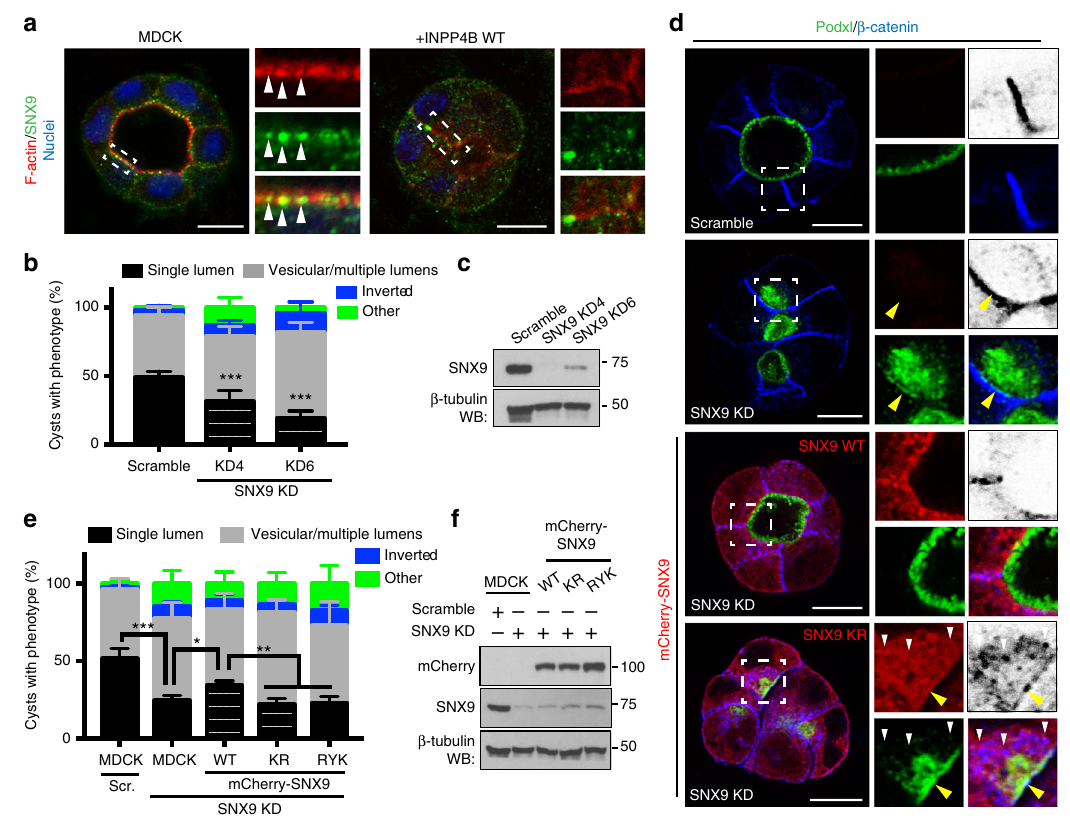
Fig. 9 SNX9-PI(3,4)P 2 association is essential for lumen formation. a SNX9, F-actin and nuclei labeling in cysts at 48 h without or with INPP4B WT overexpression. White arrowheads, subapical SNX9 puncta. b Quantitation of cyst phenotypes upon control (scramble) or SNX9 KD using two independent shRNAs. Mean ± s.d., n ≥ 300 cysts assessed from three wells/condition/experiment, three independent experiments. P- values: two-way ANOVA. *** P ≤ 0.0001. c Western blot of SNX9 and β -tubulin expression in cells stably expressing either scramble or SNX9 shRNAs. d Control (scramble) and SNX9-depleted cysts without or with co-expression of RNAi-resistant WT or PIP-binding defective mutant (KR) mCherry-SNX9 (red) stained for Podxl (green) and β -catenin (blue, inverted greyscale in cropped regions). Yellow arrowheads, basolateral; white arrowheads, vesicular β -catenin and SNX9. e Quantitation of cysts phenotypes in control (scramble) or SNX9-depleted cysts without or with expression of RNAi-resistant wild-type mCherry-SNX9 or PIP-binding defective mutants of SNX9 (KR and RYK). Mean ± s.d., n ≥ 300 cysts assessed from three wells/condition/experiment, three independent experiments. P- values: two-way ANOVA. * P ≤ 0.05, ** P ≤ 0.005, *** P ≤ 0.0001. f Total cell lysates of conditions described in e western blotted for mCherry, SNX9, and β -tubulin. All scale bars, 10 µ m